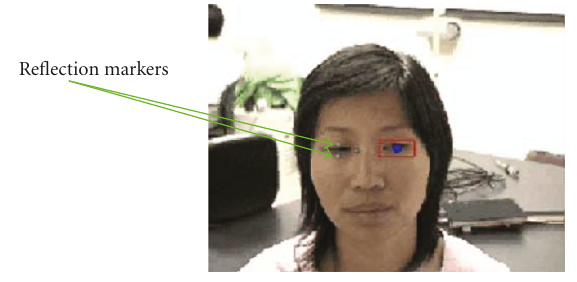
Figure 17: Marker deployment for tracking accuracy benchmark data collection.